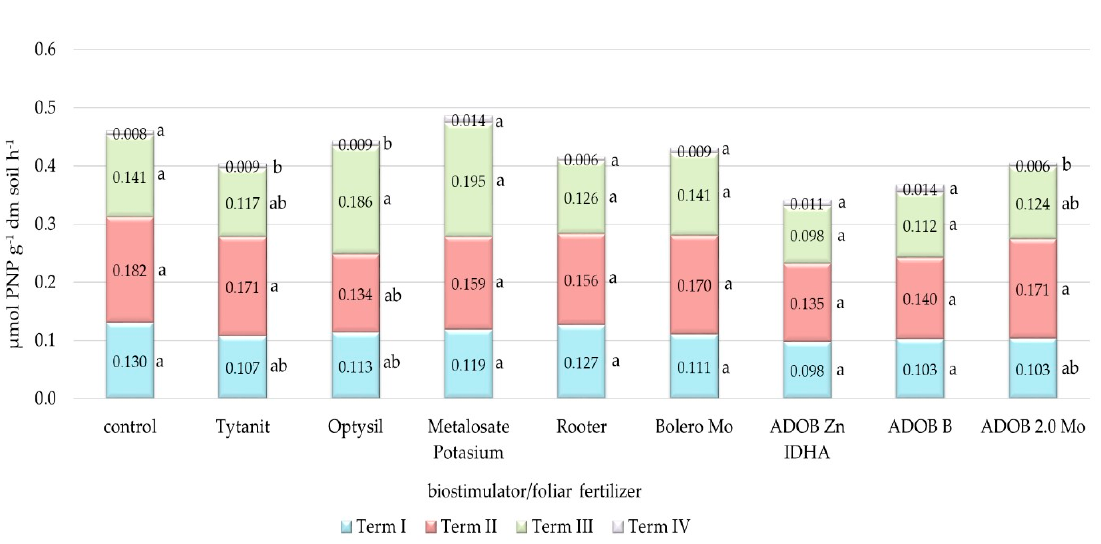
Figure 5. The influence of the bio-stimulants and fertilizers on the acid phosphatase level. Abbreviation: a, b—homogenous groups according to Duncan’s test at level p = 0.05; I term—at the plants’ emergence (BBCH 5–10), II term—at the plants’ full growth (BBCH 35–40), III term—at the